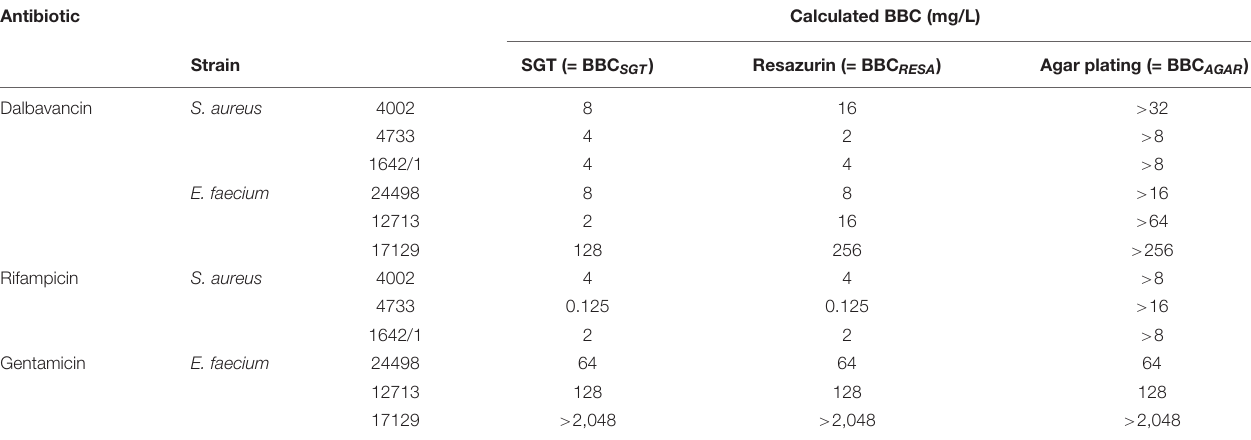
TABLE 1 | Comparison of biofilm bactericidal concentration (BBC) values obtained by different methods for biofilm quantification. Antibiotic Calculated BBC (mg/L) Strain SGT (= BBC SGT ) Resazurin (= BBC RESA ) Agar plating (= BBC AGAR ) Dalbavancin S. aureus 4002